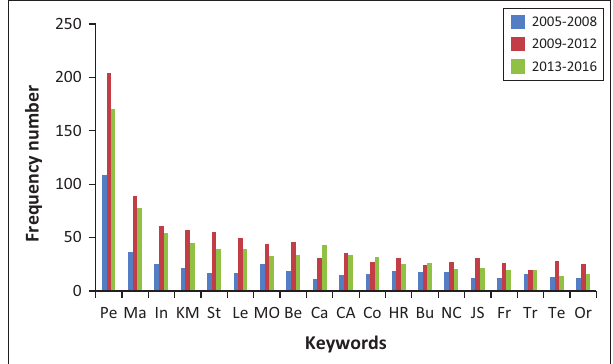
FIGURE 6: The frequency of the top 20 keywords from publications (excluding organisational culture) in three time periods.